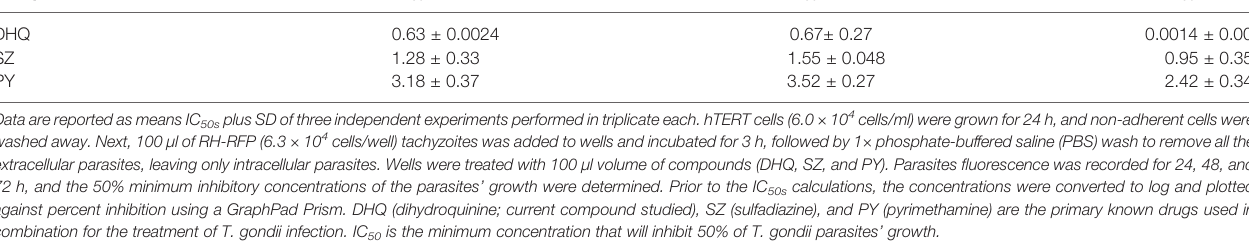
TABLE 1 | Mean kinetic IC 50s (µM) of DHQ, SZ, and PY on intracellular Toxoplasma gondii tachyzoite growth inhibition.